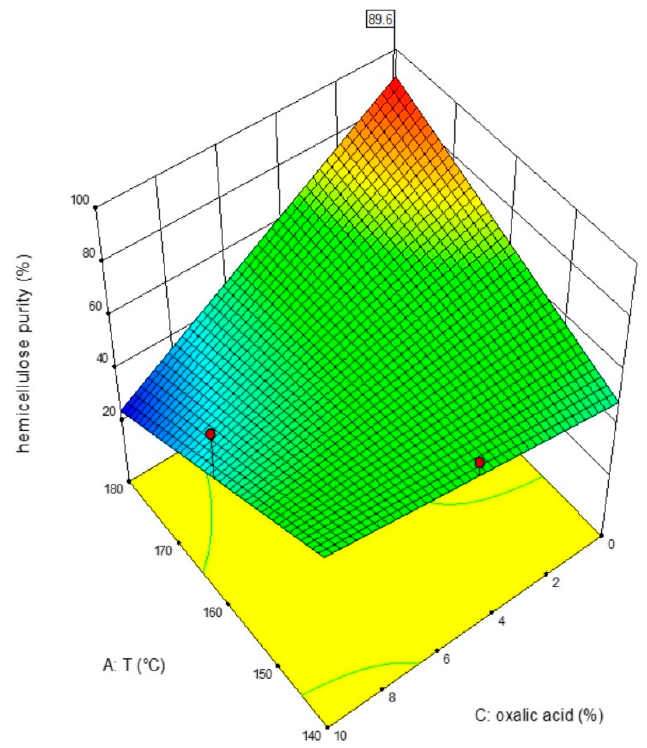
Figure 5. Purity of HF from WS pretreated with butanol as a function of temperature and oxalic acid (time = 90 min).